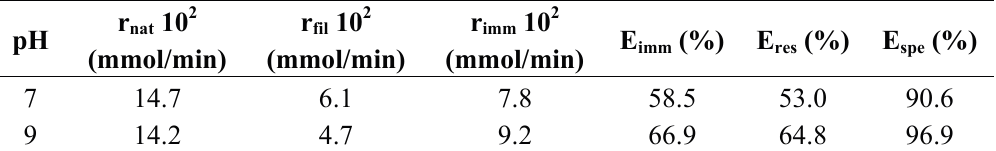
Table 3. Percentage of immobilized enzyme, E activity of the immobilized enzyme, E catalytic activity (mmol/min) of the native enzyme, r immobilization process, r the immobilized lipase on demineralized sepiolite. The immobilization was carried out at pH 7and